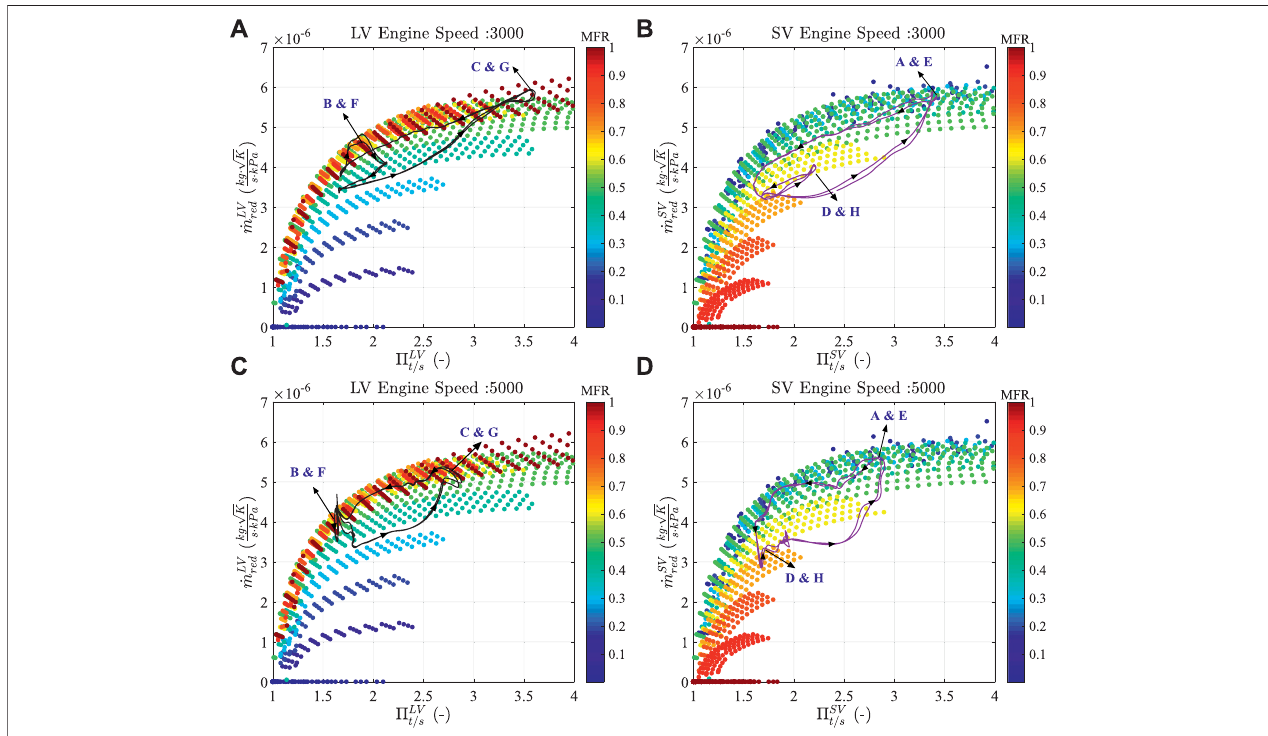
FIGURE17| Comparisonofsteady(contours)andunsteadystatereducedmass fl owparametervs.expansionratioacrosseachturbinebranchobtainedfromthe CMT-DETCM model. (A) and (B) Show the instantaneous parameters in long and short volute branches for an engine speed of 3,000 rpm; (B) and (D) show the instantaneous parameters in long and short volute branches for an engine speed of 5,000